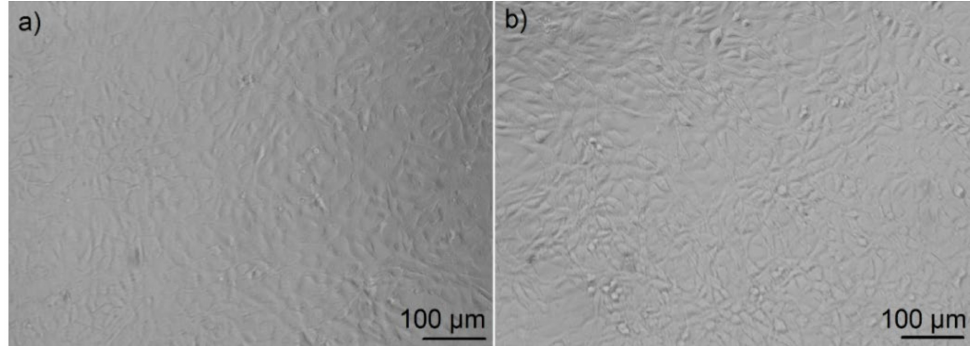
Figure 12. Light microscopy images of a layer of NIH-3Te fibroblast cells grown in well plates for evaluation of cell morphology and proliferation: ( a ) cells in media conditioned with Nusil Med 4850-PAMAA composite samples and ( b ) the negative control. Cells in both wells showed normal morphology and proliferated as expected.